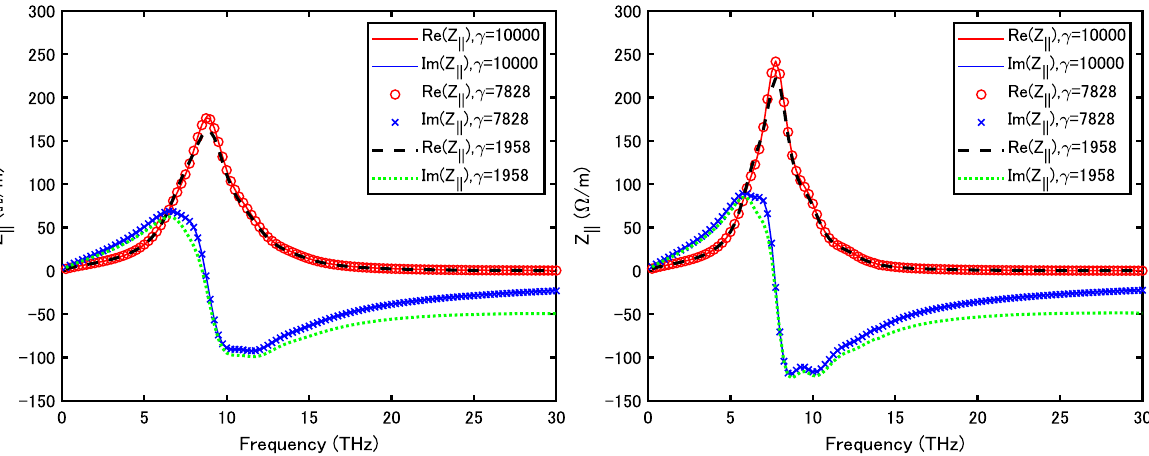
FIG. 10. ASE resistive-wall impedances of racetrack-type vacuum chambers for different metals: (left) aluminum and (right) copper. All computations are performed with the proposed BEM for γ ¼ 10 000 , 7828, and